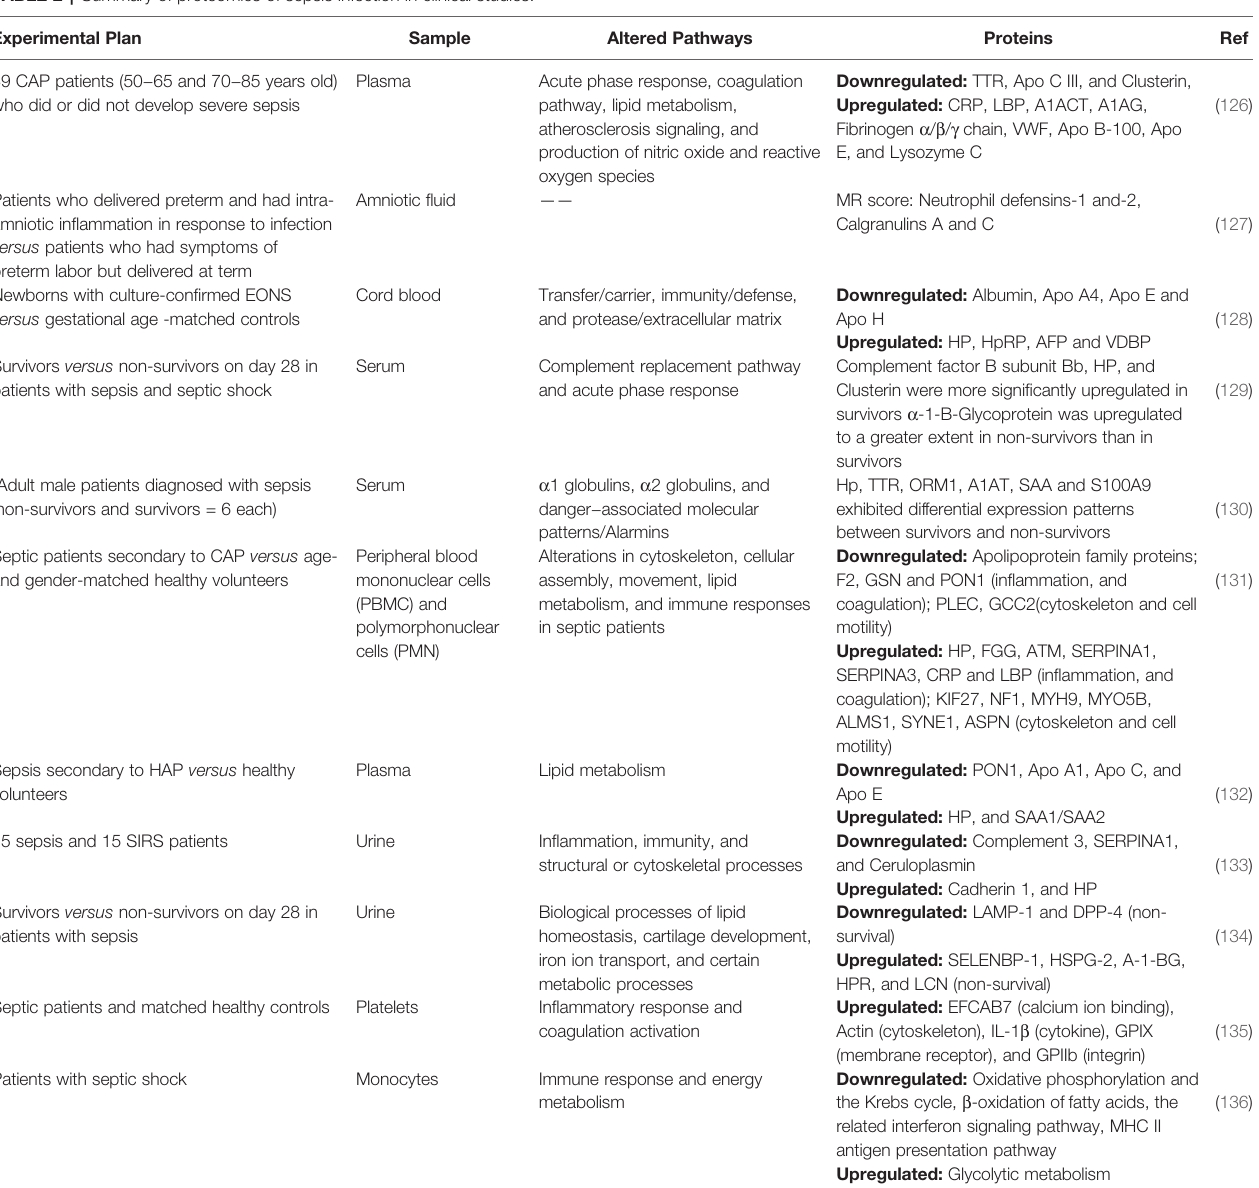
TABLE 2 | Summary of proteomics of sepsis infection in clinical studies. Experimental